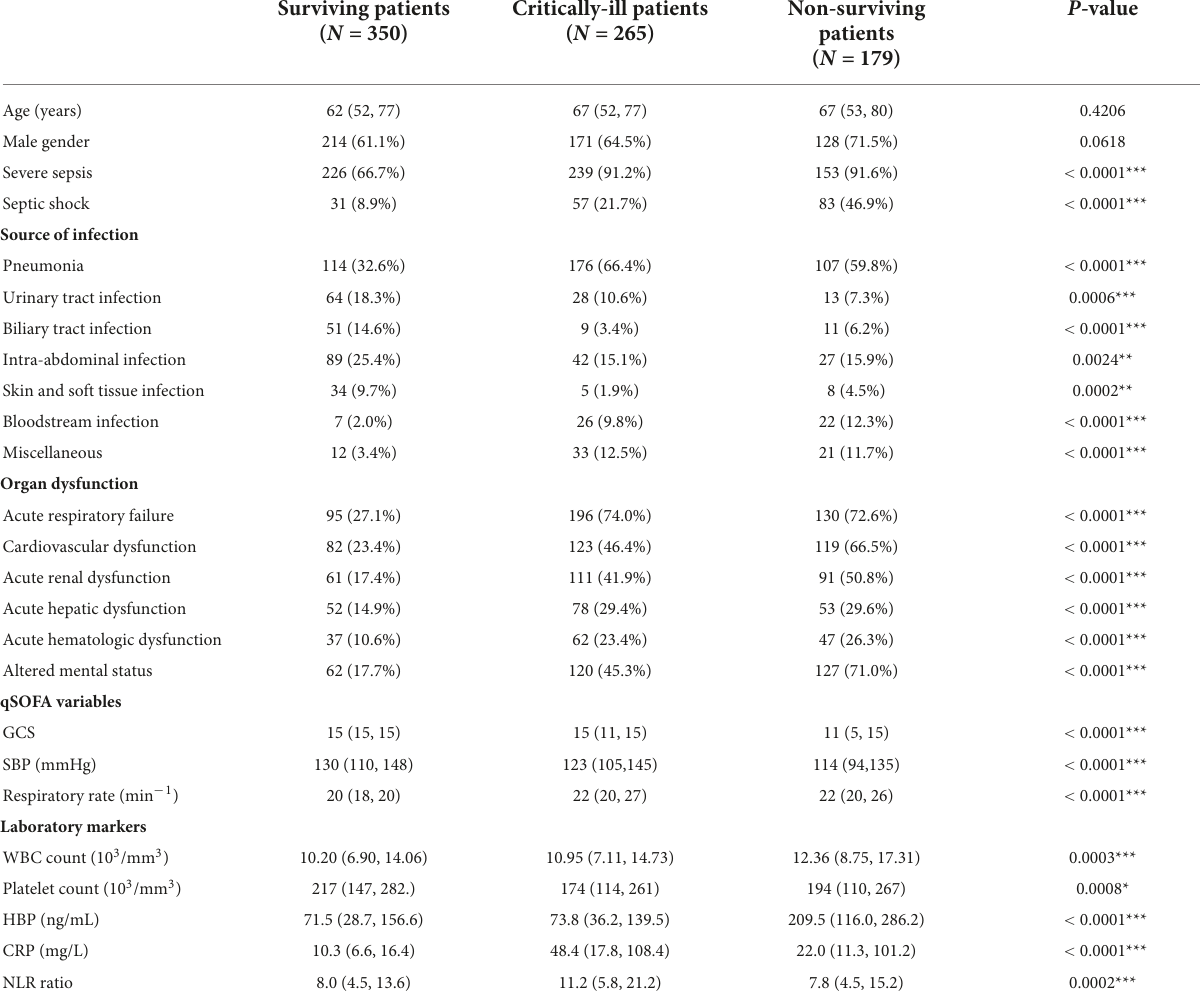
TABLE 1 Characteristics of the study patients, stratified by three different severity